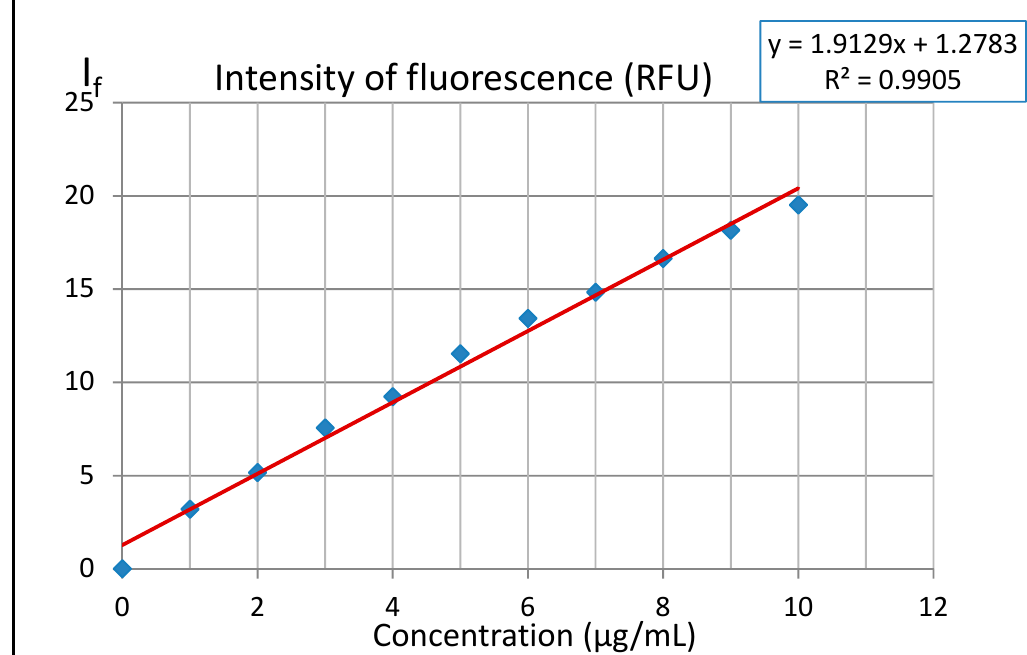
Figure 8. Fluorescence emission intensity dependence as a function of 3-aminoflavone concentration in methanol fitted with a linear function. The cuvette thickness l was 1 cm. For excitation and emission, filters with wavelengths of 350 nm and 470 nm were used, respectively.